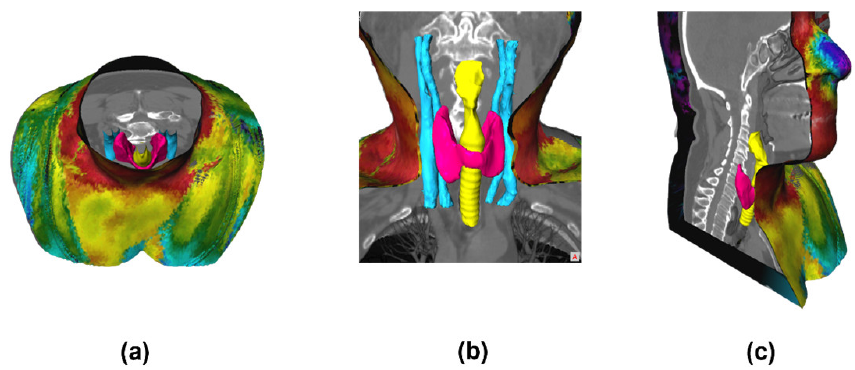
Figure 20. 3D visualization of the complete model, showing the structures in different sections/slices: ( a ) axial, ( b ) coronal, and ( c ) sagittal. A video overview illustrating these results can be found in the Supplementary Material (Video S1).